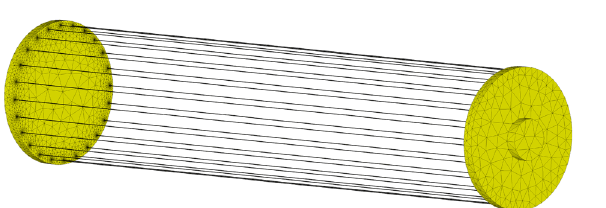
Figure 8. Discretized model of the interior of the fuse compartment consisting of 24 parallel fusible elements (300 mm long and 0.25 mm or 0.125 mm in